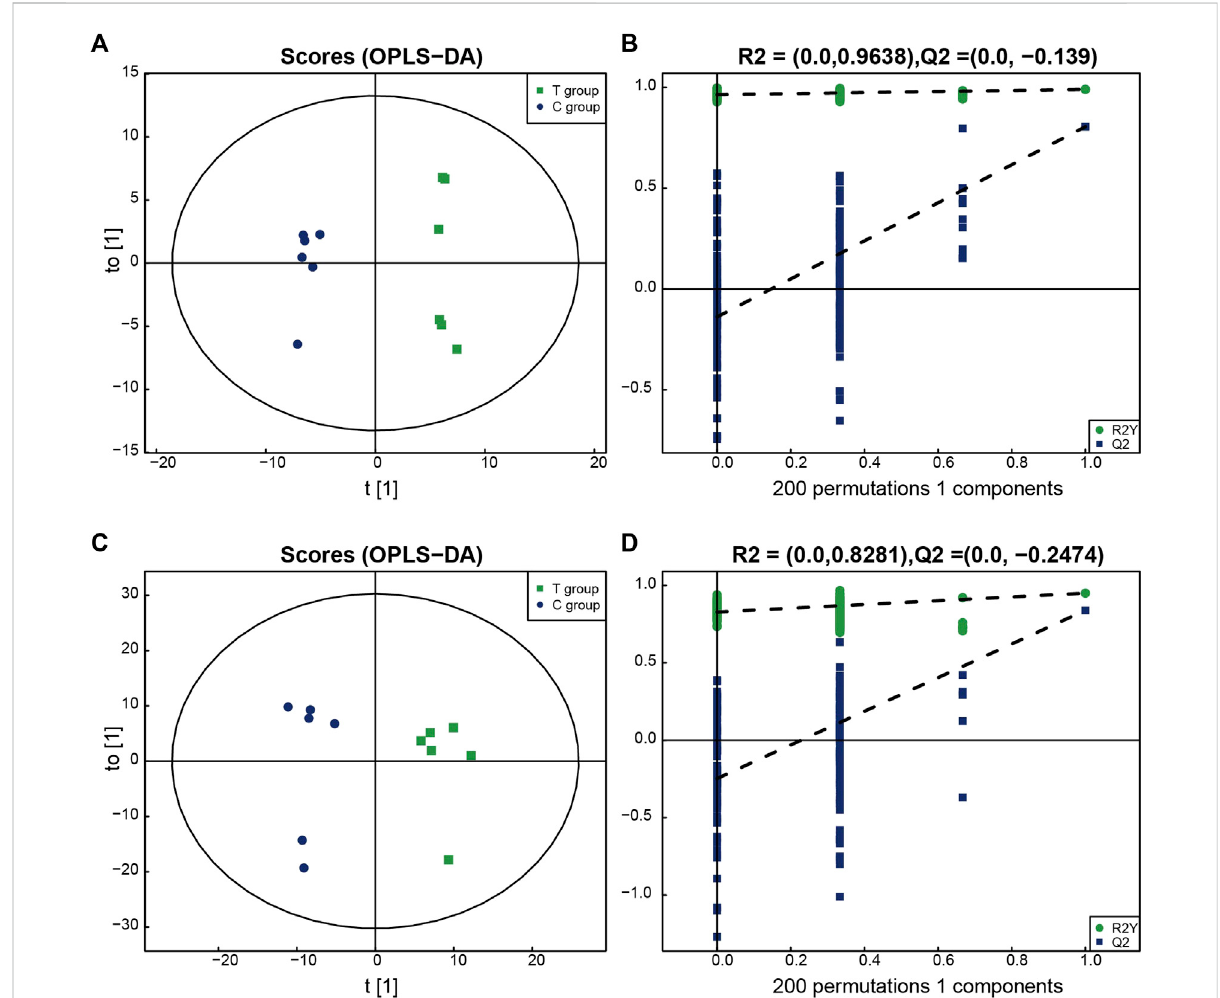
FIGURE 2 The multidimensional results in positive and negative ionization modes are shown in this fi gure. (A,B) OPLS-DA score plot and OPLS-DA validation plot intercepts in positive ionization modes: the Treated group vs. the Control group. R2Y = (0.0, 0.9638), Q2 = (0.0, − 0.139). (C,D) OPLS- DA score plot and OPLS-DA validation plot intercepts in negative ionization modes: the Treated group vs. the Control group. R2Y = (0.0, 0.8281), Q2 = (0.0, −